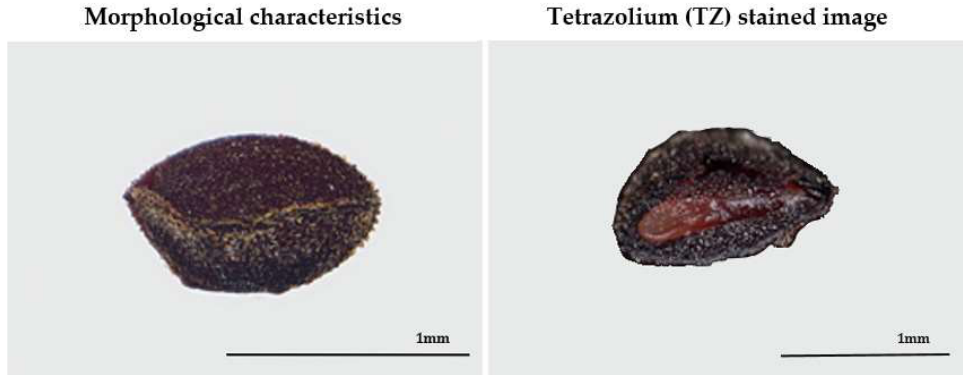
Figure 1. Morphology of a Lysimachia coreana seed. The left image shows the texture and morpho- logical characteristics, and the right image shows the cross-section of the seed with the tetrazolium- stained embryo structure. Images were taken using a digital microscope. Scale bars: 1 mm.